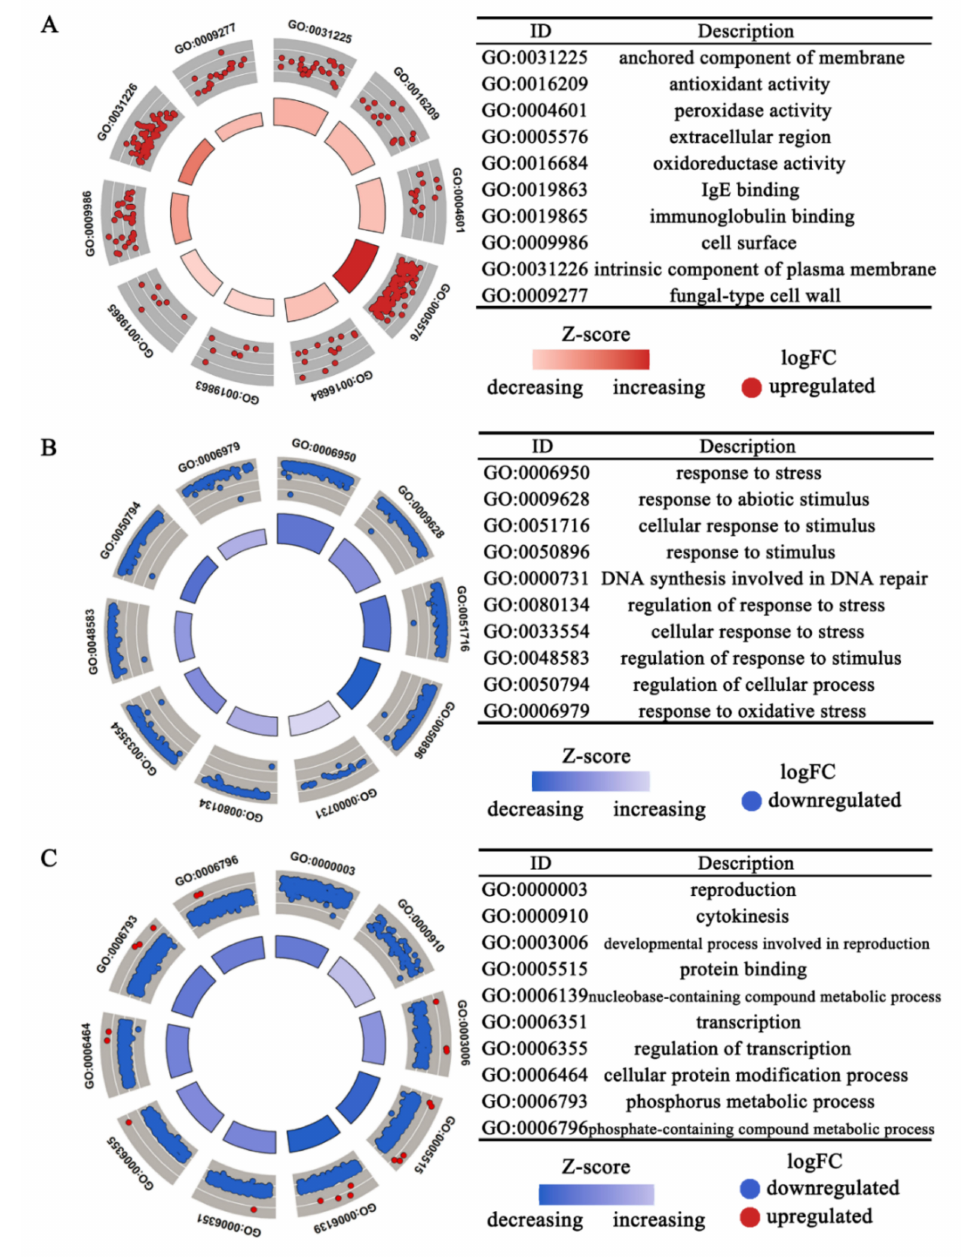
Figure 3. Summary of Gene Ontology (GO) terms enriched with the differentially expressed genes (DEGs) regulated by ET at 4 hpi and 24 hpi. ( A ) GOCircle showing the DEGs of the top 10 upregulated GO terms at 4 hpi. ( B ) GOCircle displaying the DEGs in the top 10 downregulated GO terms at 4 hpi. ( C ), GOCircle showing the DEGs of the top 10 GO terms at 24